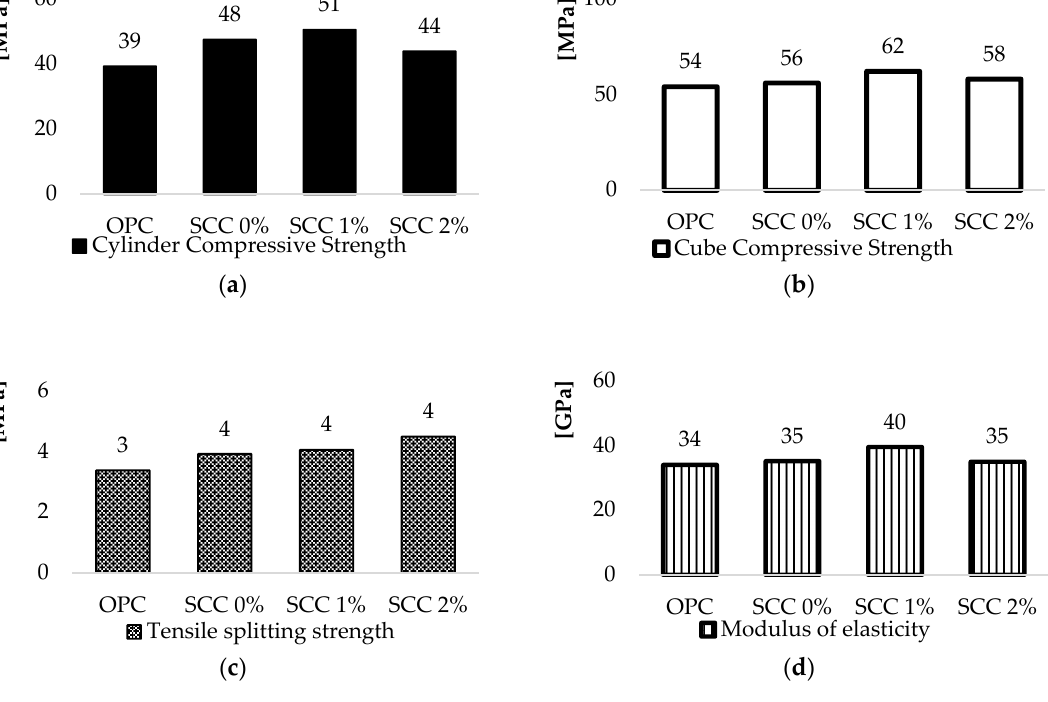
Figure 2. Results of material characteristics for all mixtures: ( a ) cylinder compressive strength; ( b ) cube compressive strength; ( c ) tensile spitting strength; ( d ) modulus of elasticity [31].